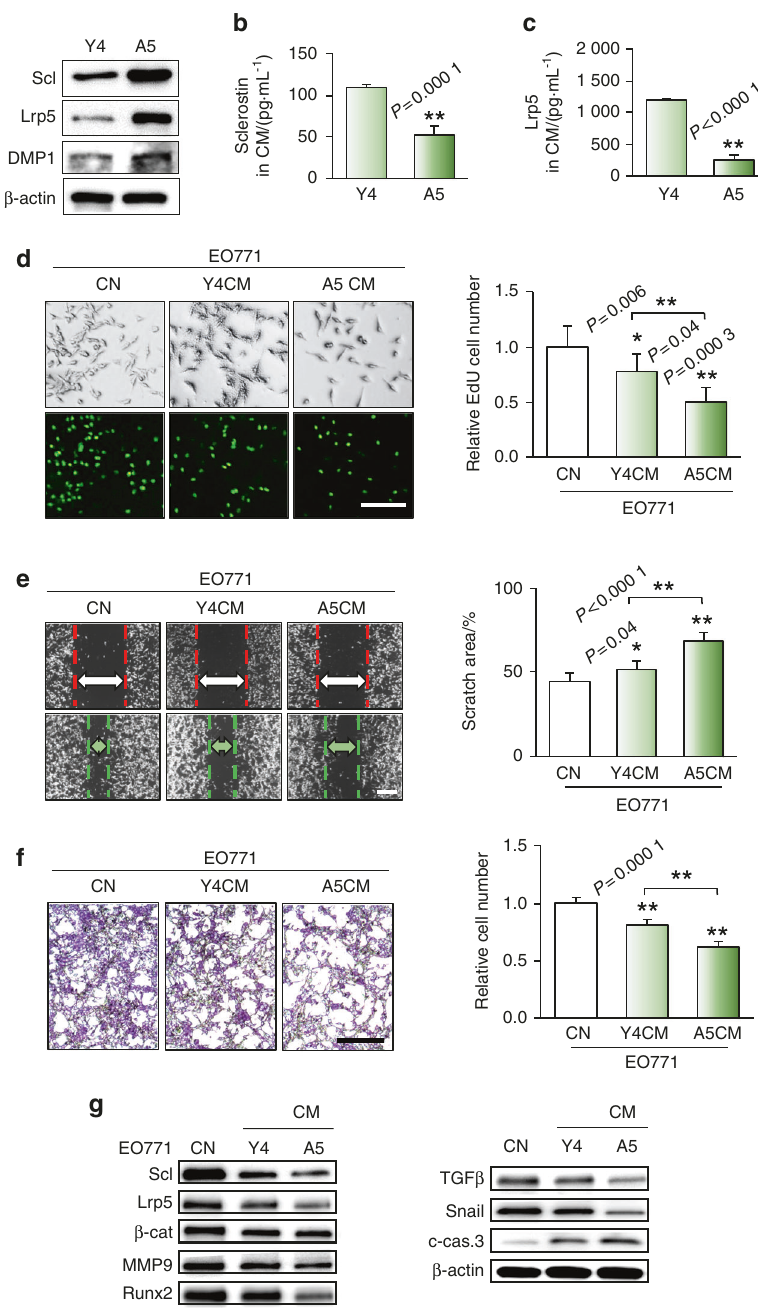
Fig. 1 Osteocyte-driven inhibition of tumorigenic behaviors of EO771 mammary tumor cells. CN control (plain medium), CM conditioned medium, A5 differentiated MLO-A5 osteocytes, Y4 MLO-Y4 osteocytes, Scl sclerostin, and β -cat β -catenin. The single and double asterisks indicate P < 0.05 and P < 0.01, respectively. a Elevated levels of Sclerostin (Scl), Lrp5, and DMP1 in differentiated MLO-A5 osteocytes compared to MLO-Y4 osteocytes. b , c Lower levels of Scl and Lrp5 in A5 CM than in Y4 CM. d – f Signi fi cant reductions in the proliferation (as assessed by an EdU incorporation assay), migration (as assessed by a wound-healing assay), and invasion (as assessed by a Transwell assay) of EO771 mammary tumor cells by Y4 CM and A5 CM compared to control (plain medium). Scale bar: 200 μ m. g Reductions in the levels of Scl, Lrp5, β -catenin, MMP9, Runx2, TGF β , and Snail with an increase in cleaved caspase 3 in EO771 cells in response to Y4 CM and A5 the ability of osteocytes to protect against cancer-induced control group (injected with only tumor cells) exhibited clear osteolysis. No bene fi ts of osteocyte coinjection were observed tumor-linked lesions in the tibia, which were signi fi cantly reduced when osteocytes expressing Lrp5 shRNA were used. Evaluation of in the A5-injected group (Fig. 4a). Furthermore, μ CT imaging H&E-stained sagittal sections revealed that the osteocyte-injected revealed that osteocyte coinjection reduced tumor-driven osteo- lysis (Fig. 4b). In response to the coinjection, the bone volume ratio (BV/TV) and trabecular number (Tb.N) were elevated, and the trabecular separation (Tb.S) was reduced. These changes suggest